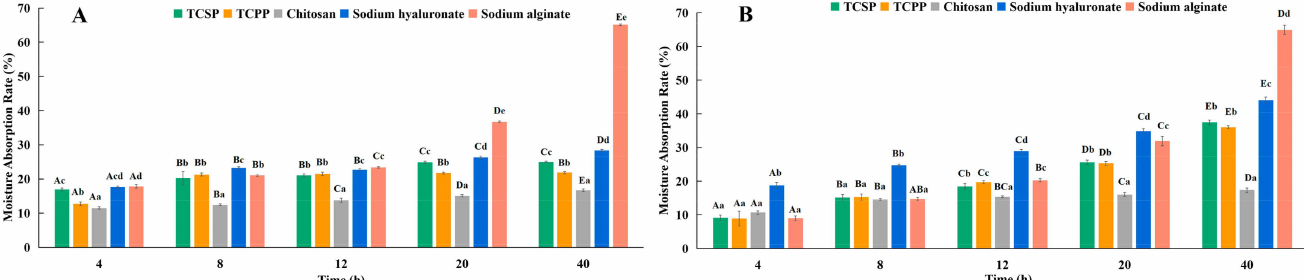
Figure 2. Moisture absorption of TCSP, TCPP, chitosan, sodium hyaluronate and sodium alginate for indicated times, A (81% RH) and B (43% RH). Capital letters represent inter-group differences, and lowercase letters represent intra-group differences. TCSP: polysaccharides from stems of Trollius chinensis Bunge; TCPP: polysaccharides from petals of Trollius chinensis